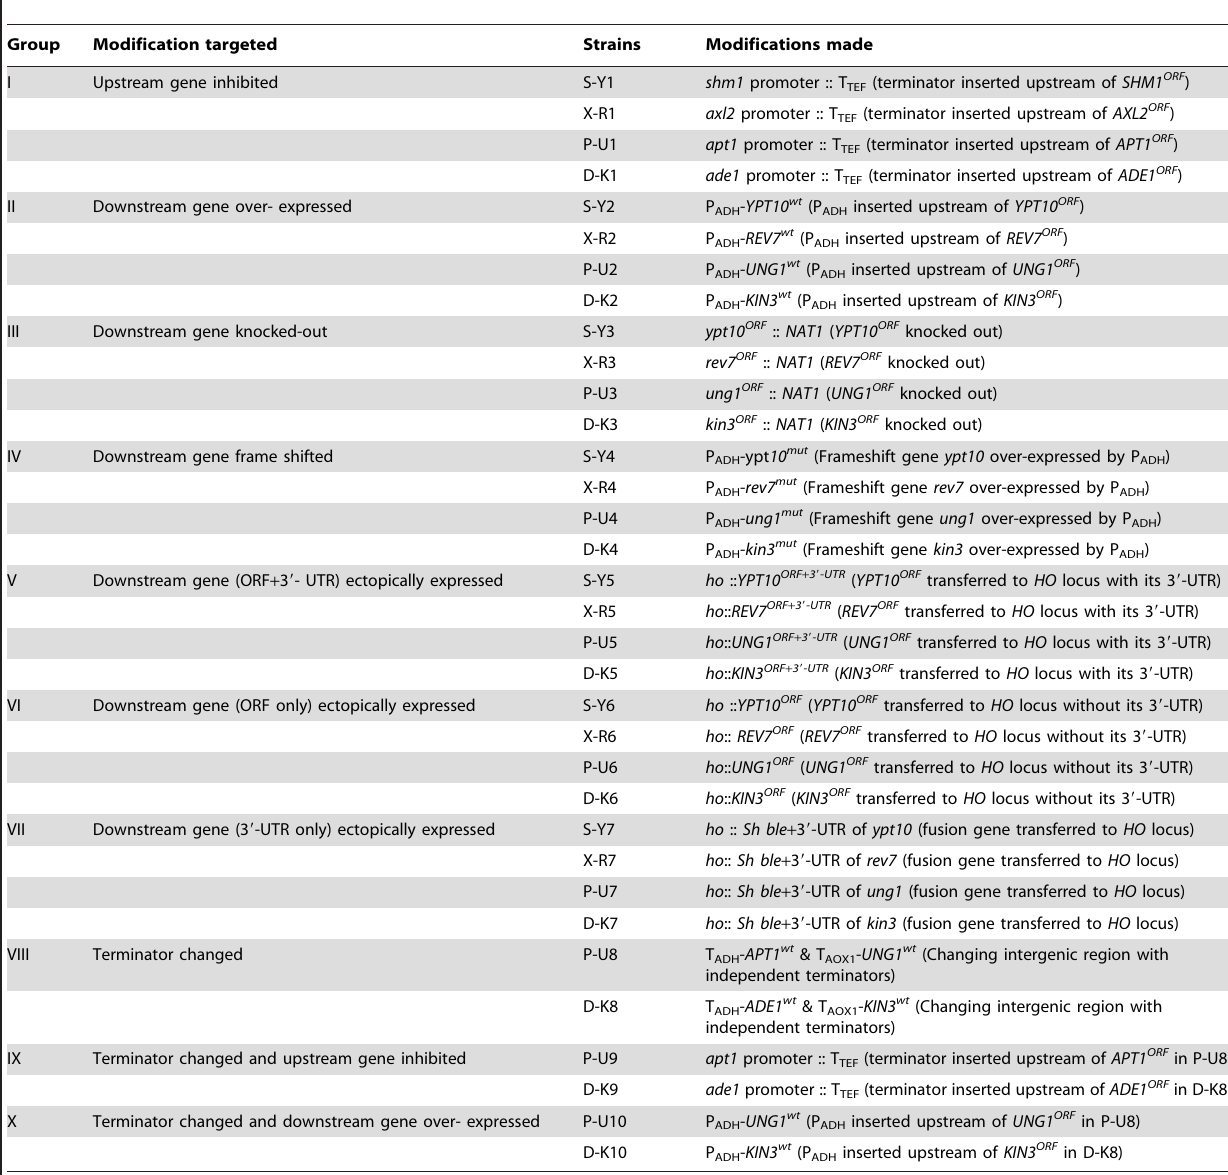
Table 2. Summary of genetically modified strains of the standard wild type yeast YL1C.